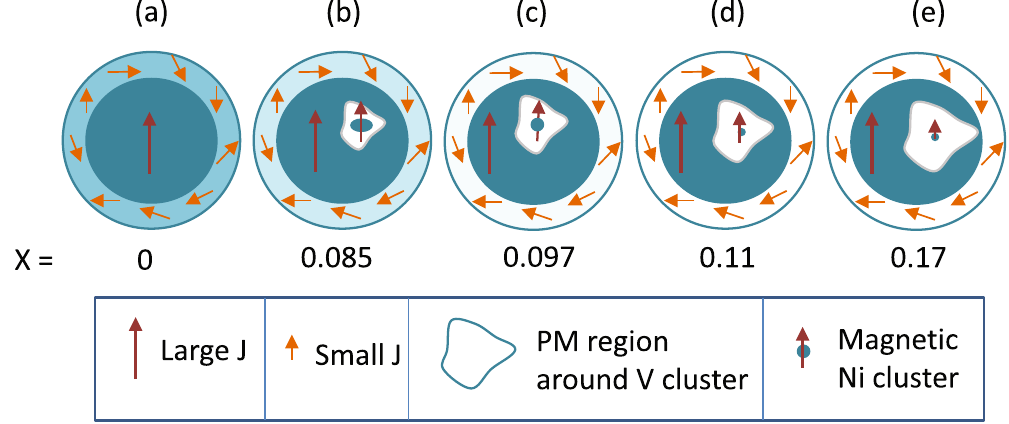
Figure 7. Schematic pictures of nanoparticle magnetic structures at x = 0 ( a ), 0.085 ( b ), 0.098 ( c ), 0.11 ( d ) and 0.17 ( e ). Large J : spins with large FM exchange interaction (dark cyan) giving rise to a single large moment, small J : spins with weak FM exchange interaction (lighter cyan). Lighter shade implies weaker exchange interaction.